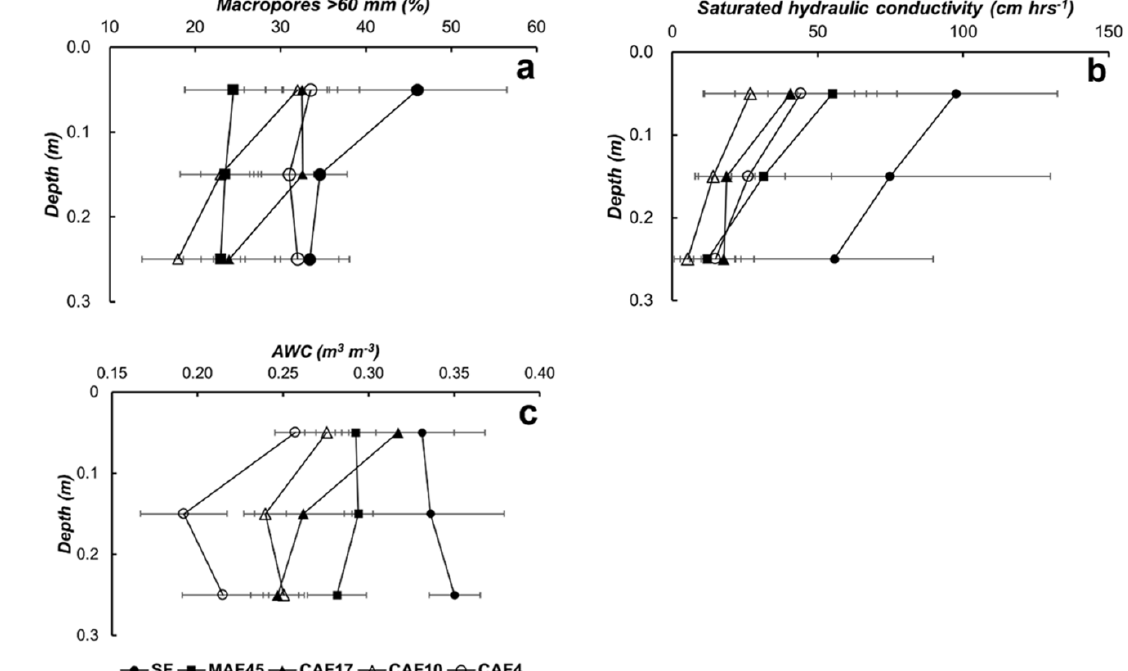
Figure 5. Changes of soil surface (0–30 cm depth) macro–porosity ( a ), saturated hydraulic conductivity ( b ) and available water capacity ( c ), resulted from shifting forest to cocoa farms and its restoration through aging cocoa agroforestry systems that are 4–5 years old (CAF4), 10–12 years old (CAF10), and 17–34 years old (CAF17), and through multistrata agroforest that is 45–68 years old (MAF45). Bars are standard errors of the